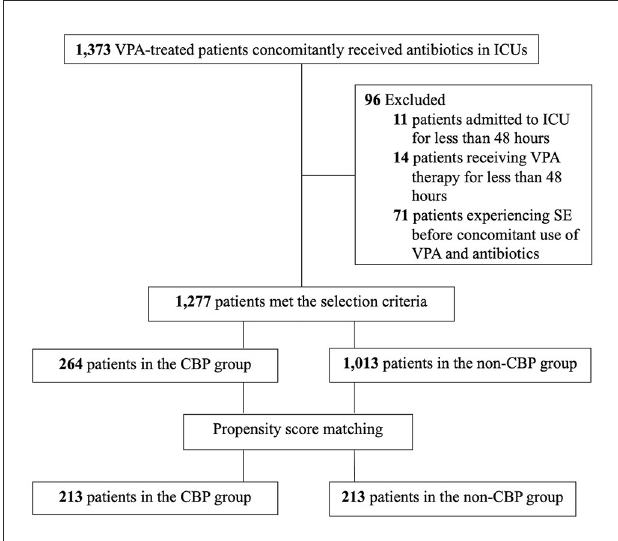
FIGURE1 The enrollment flowchart of critically ill patients treated with VPA and concomitant antibiotics. CBP, carbapenem antibiotics; ICU, intensive care unit; SE, status epilepticus; VPA, valproic acid.